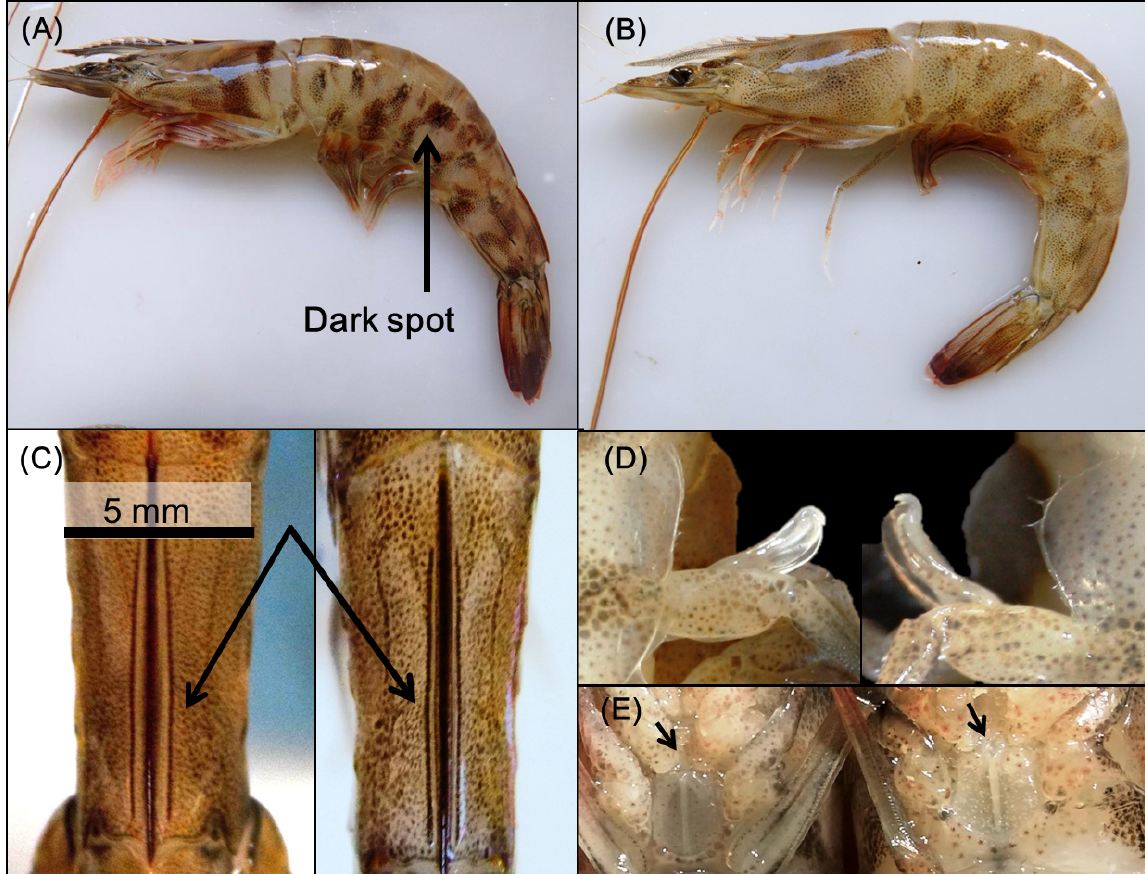
Figure 3. Diagnostic characteristics used for identification of Farfantepenaeus brasiliensis and F. paulensis . (A) dark spot observed at the junction of the third and fourth abdominal somite in F. brasiliensis ; (B) lack of this spot in F. paulensis ; (C) dorsal-lateral furrow of the sixth abdominal somite widened in F. brasiliensis (left) and narrowed in F. paulensis (right); (D) short distomedial projection of petasma in males, with the dorsal part very curved and closed in F. brasiliensis (left) and slightly curved and open in F. paulensis (right) and (E) anterior portion of the side plates in females, covering the posterior process in F. brasiliensis (left) and not covering the posterior process in F. paulensis